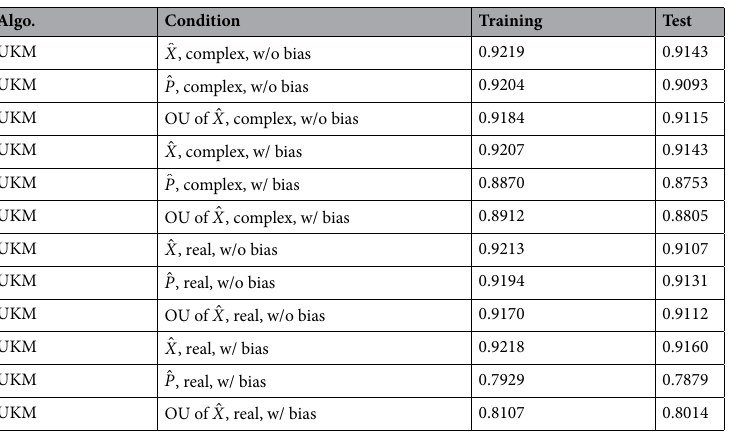
Table 3. Results of 5-fold cross-validation (CV) with 5 different random seeds for the cancer dataset (0 or 1). We show the performance obtained by ˆ X , ˆ P , and OU of ˆ X . We consider real and complex matrices for the initial input with and without the bias term. We set r = 0.010 and K = 30 . We repeat the CG iteration for Eq. (20) 10 times in each step of the method of SOC. Due to the inherent formulation of the method of SOC, ˆ X does not strictly satisfy the unitarity condition; ˆ P and OU of ˆ X strictly satisfy the unitarity condition, yielding VQCs. The overall higher performance of ˆ X can be attributed to it being a classical classifier; a special case of the kernel method. Note, however, that the classifier created by the UKM without bias yield better performance than the best classifiers created by QCL, as shown in Table 2.